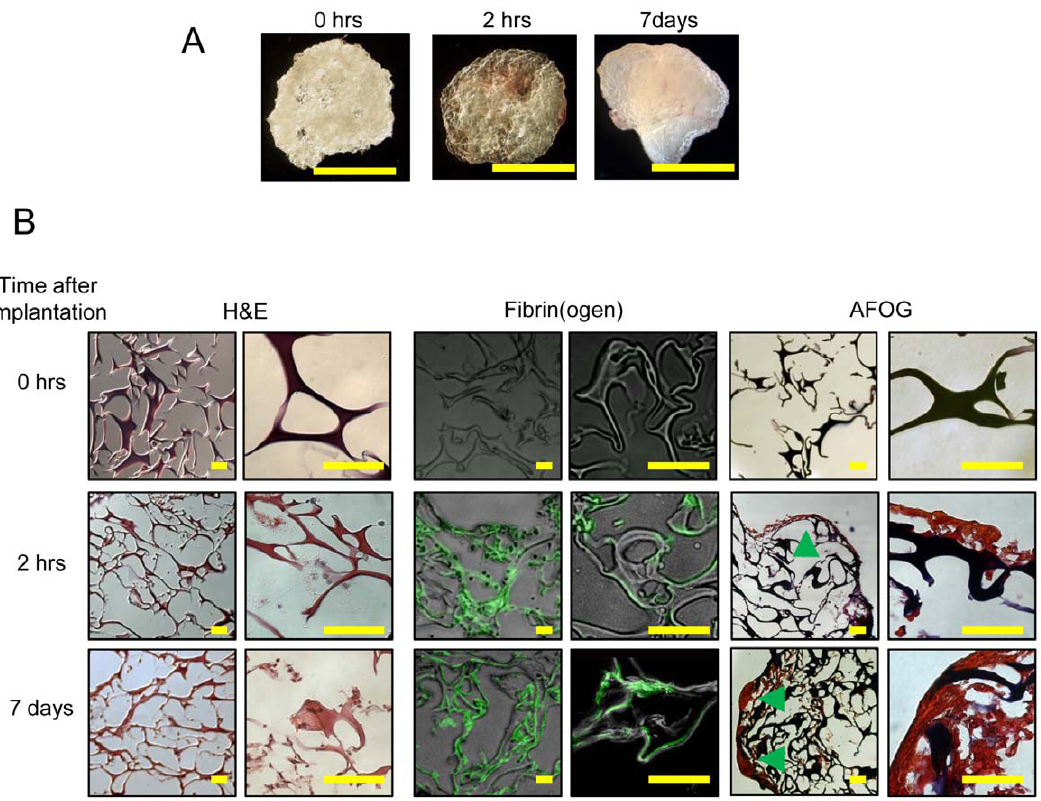
Figure 1. Gelfoam hydrogels explanted from the peritoneal cavity of mice are encased within a fibrin matrix. (A) Photomicrographs of explanted Gelfoam sponges at various time points. (B) Explanted Gelfoam sponges were characterized by immunohistochemistry and immunofluorescence. Sections were stained with hemotoxylin and eosin (H&E), fibrin(ogen), and acid fuschin orange –G (AFOG). Green arrows indicate fibrin deposition within the Gelfoam sponge. Scale bars, (A) 10 mm; (B) 50 m m.